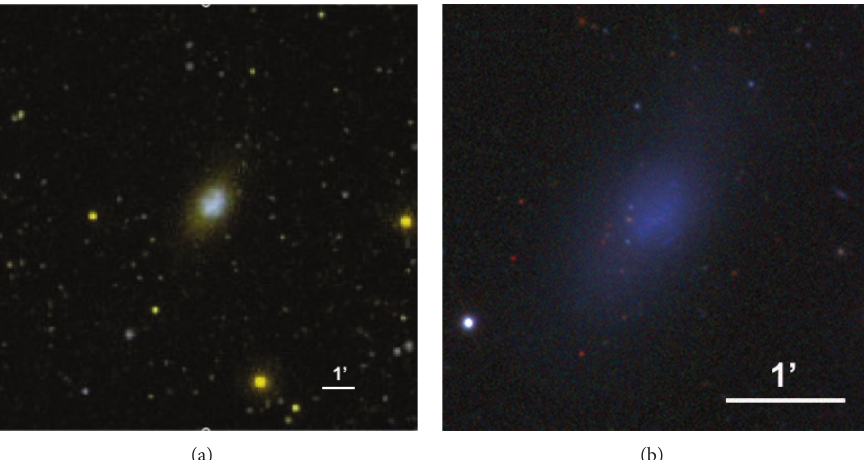
Figure 1: (a) Composite 13 󸀠 × 13 󸀠 GALEX image of UGC 7639. Blue and yellow correspond to FUV and NUV. (b) Composite 3 󸀠 .6 × 3 󸀠 .6 SDSS (gri) image of UGC 7639. Note the outstanding, innermost blue patches, which are also weak H 𝛼 emitters.